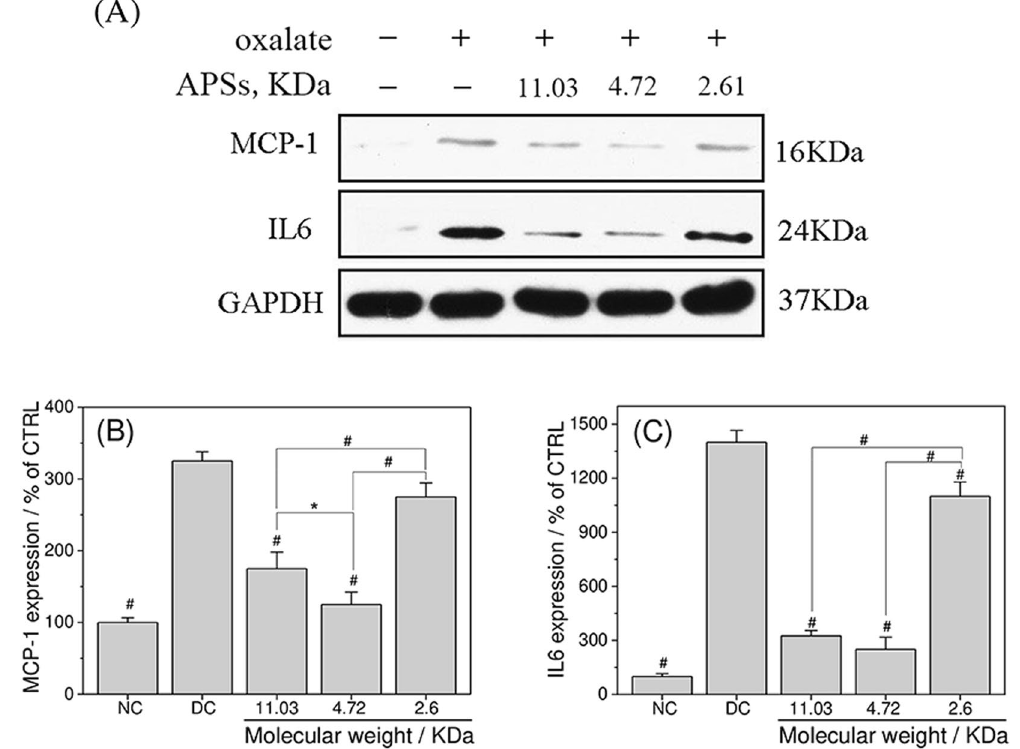
Figure 11. APSs with different Mws inhibited oxalate-induced inflammation level. Protein expression levels of MCP-1 and IL-6 were detected by Western blot analysis ( A ). Protein expression levels of MCP-1 ( B ) and IL-6 ( C ) were quantified by Imagel